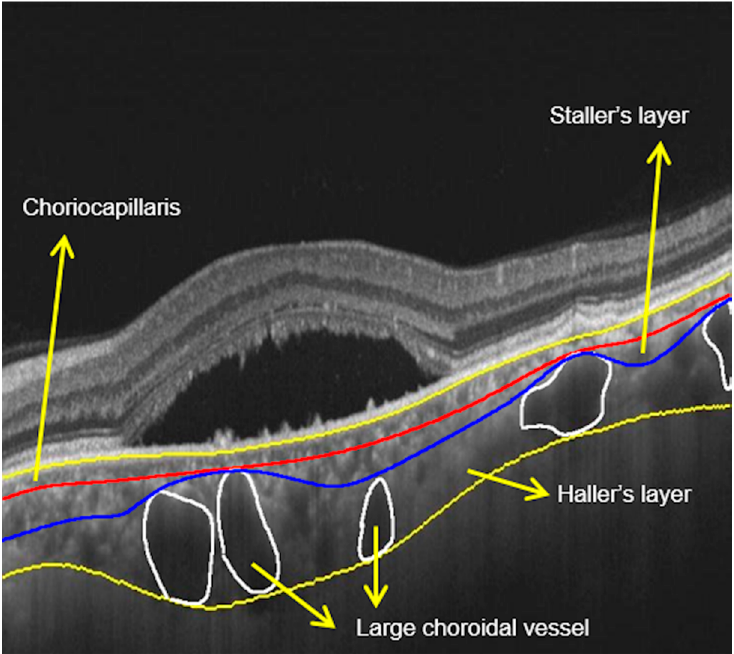
Figure 7. Haller’s layer measurements: scan showing neurosensory detachment with demarcation of various layers of choroid. Large choroidal vessels are marked, and three layers of the choroid are marked.